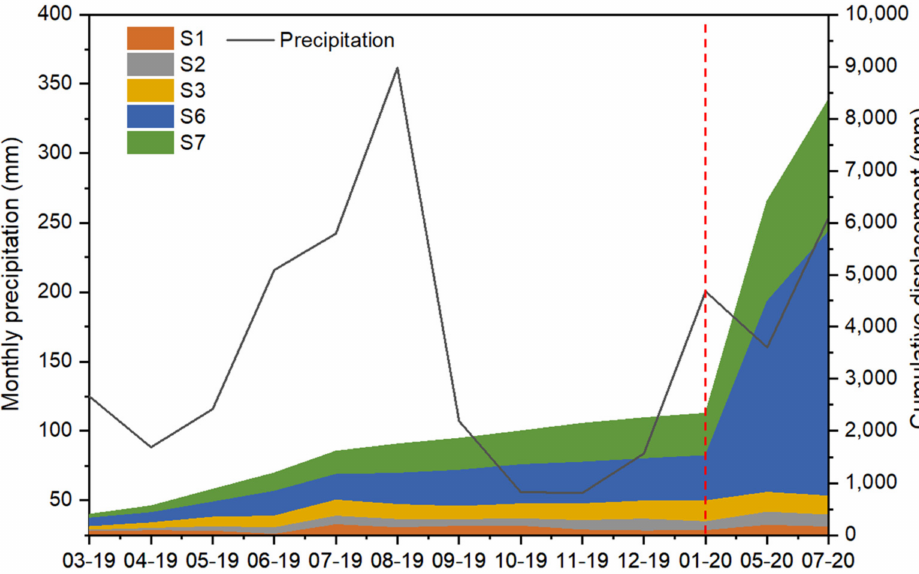
Figure 4. Ground measurements of horizontal displacement from March 2019 to July 2020. The red dashed line indicates the massive deformation event. The locations of the deformation points are shown in Figure